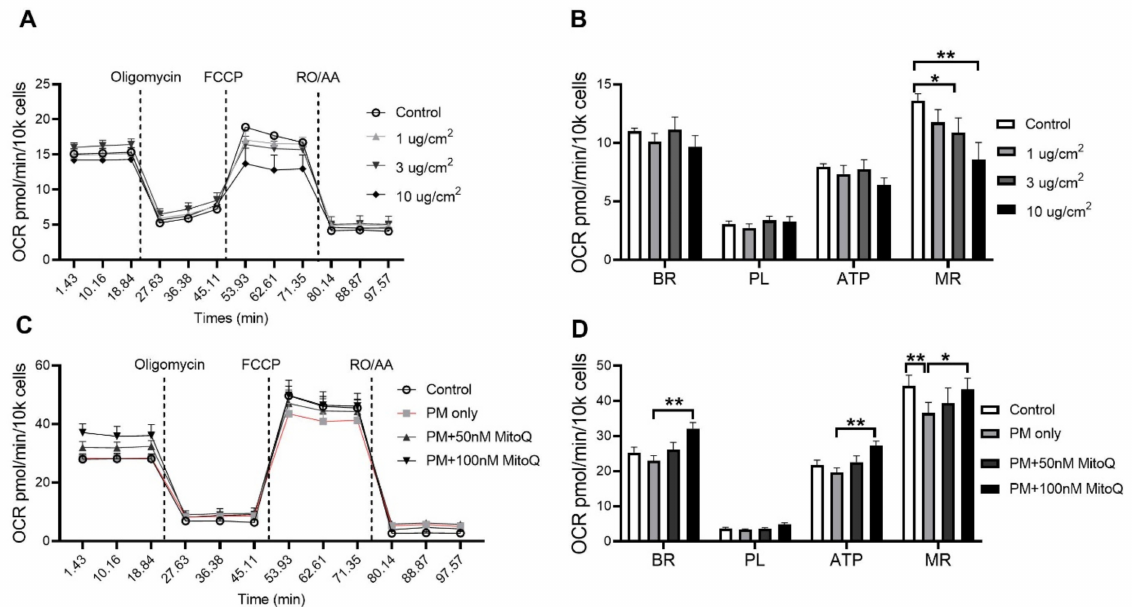
Figure 9. PM exposure reduced mitochondrial respiration in the BEAS-2B cells which was reversed by MitoQ. ( A , B ) Mitochondrial respiration in the BEAS-2B cells after PM exposure with 1 µ g/cm 2 , 3 µ g/cm 2 and 10 µ g/cm 2 followed by ( C , D ) MitoQ treatment. Data were analysed by one-way ANOVA followed by Fisher’s LSD post hoc tests. * p < 0.05, ** p < 0.01. FCCP: carbonyl cyanide-p-trifluoromethoxyphenylhydrazone; RO: Rotenone; AA: Antimycin A; OCR: Oxygen consumption rate; ATP: ATP-linked Respiration; BR: Basal Respiration; MR: Maximal Respiration; PL: Proton Leak-linked Respiration; PM: Particulate